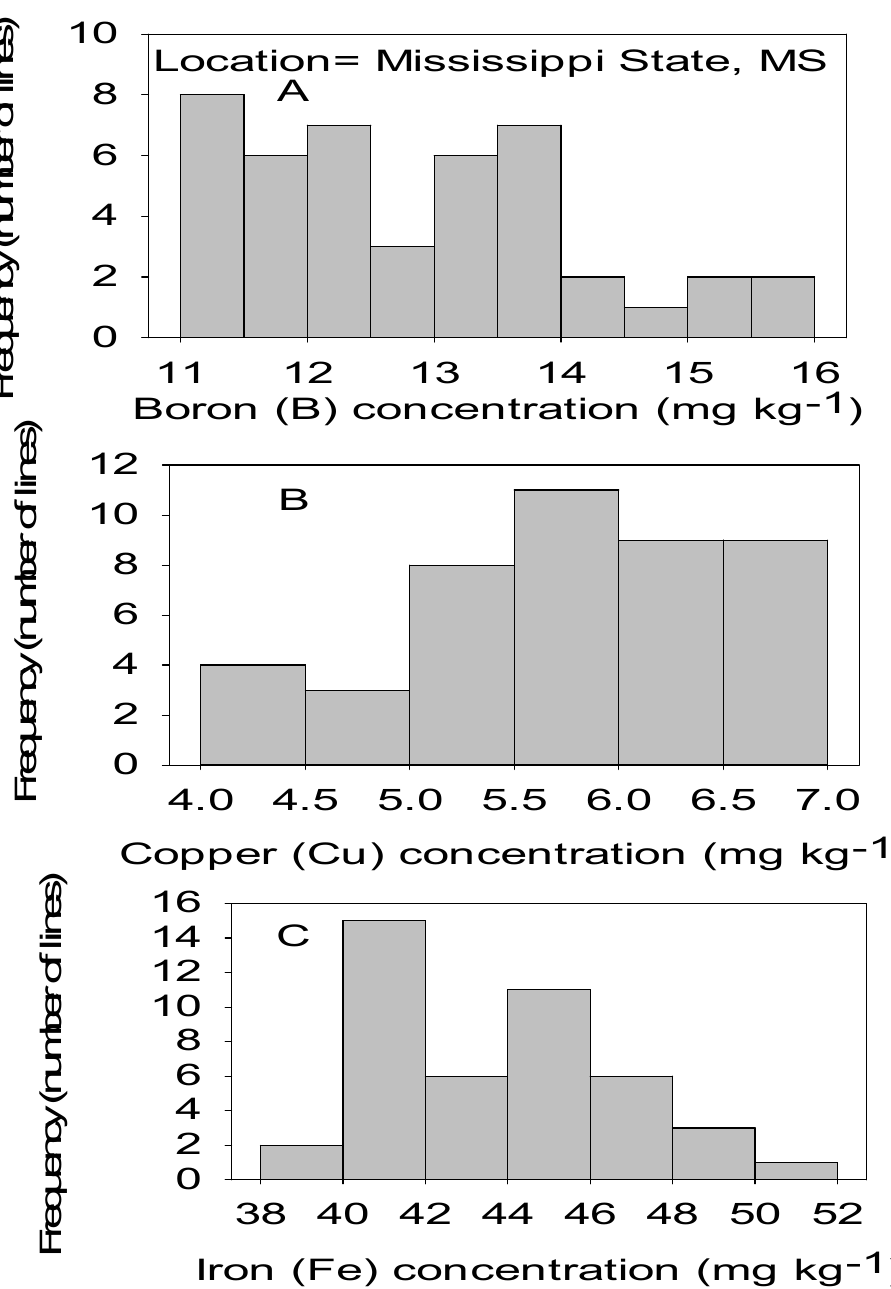
Figure 3. Distribution of micronutrients B ( A ), Cu ( B ), and Fe ( C ) in cottonseed in CS lines in cotton in Mississippi, MS, USA.